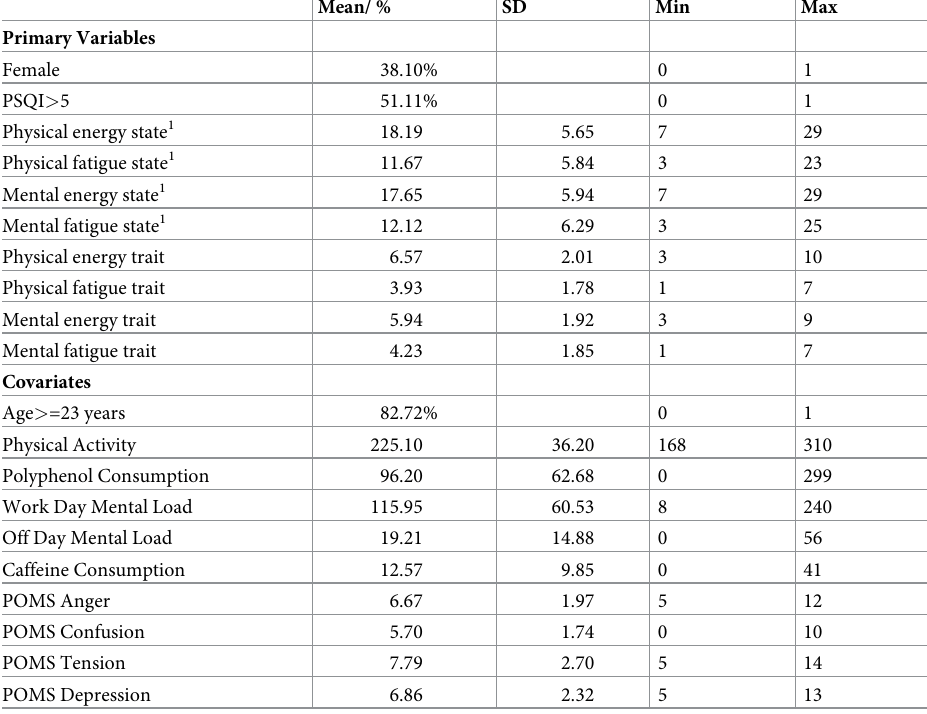
Table 1. Summary statistics for outcomes and covariates (N =